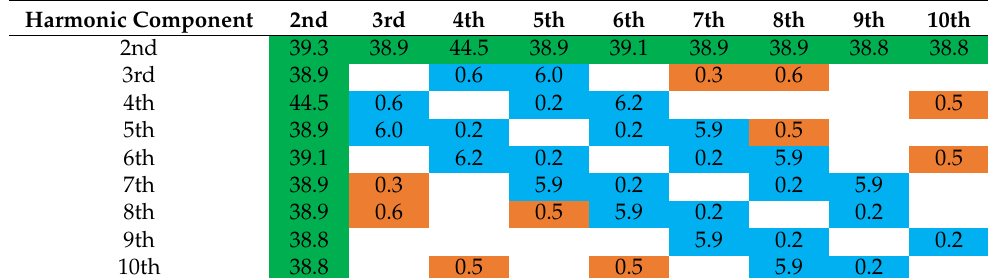
Table 1. The maximum produced BSV [%] of component pairs 3–10. The pairs marked as white do not produce BSV, while the colored pairs produce. The different colors divide the components into three different groups; the green group includes the pairs containing the BSV-producing second component, the blue group includes the components that produce BSV with the next two lower and upper components, and the orange group includes the component pairs that are systematically scattered between green and blue